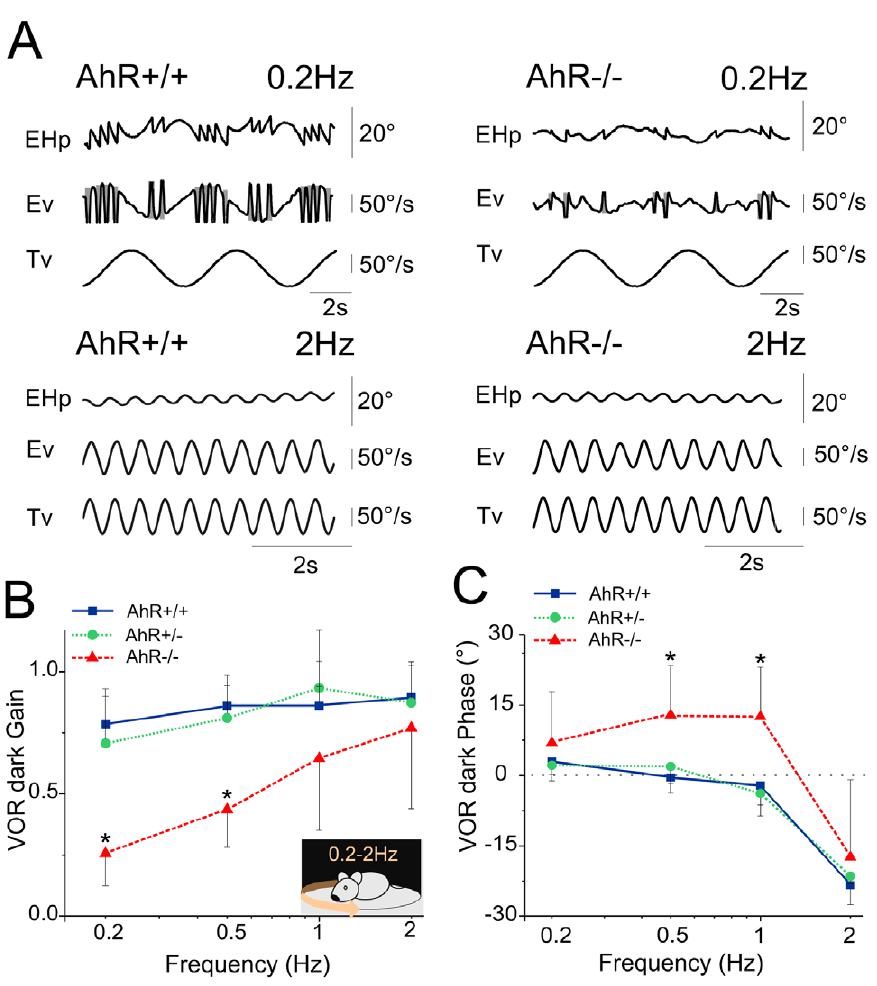
Figure 2. Normal vestibular function in AhR 2 / 2 mice. (A) Example of eye movements evoked in AhR + / + ( left ) and AhR 2 / 2 ( right ) during sinusoidal oscillation in the horizontal plan at a peak velocity of 50 u /s. top : frequency of the oscillation equal to 0.2 Hz; bottom : frequency of 2 Hz. Shaded areas indicate quick phases. At low frequency, the nystagmus overlaps the normal VOR pattern. At high frequency, both AhR + / + and AhR 2 / 2 mice show comparable reflexive eye movements. (B–C), Gain (B) and phase (C) of the VOR in the dark. Blue lines correspond to the AhR + / + mice, green lines correspond to the AhR + / 2 mice and red lines correspond to the AhR 2 / 2 mice. At low frequency, the VOR gain and phase in the AhR 2 / 2 mice decreased compared to the AhR + / + mice. At high frequency, VOR gain and phase did not differ from that of other groups suggesting that the vestibulo-ocular reflex is not affected in the AhR 2 / 2 mice. Asterisk indicates statistical difference with p , 0.05, EHp, Eye Horizontal position; EVp, Eye Vertical position; Ev, Eye velocity; Tv, Table velocity. In this and all following figures: head velocity traces have been inverted to facilitate comparison with eye velocities; the phase lead is positive (up); plots present mean 6 Standard Deviation (SD).